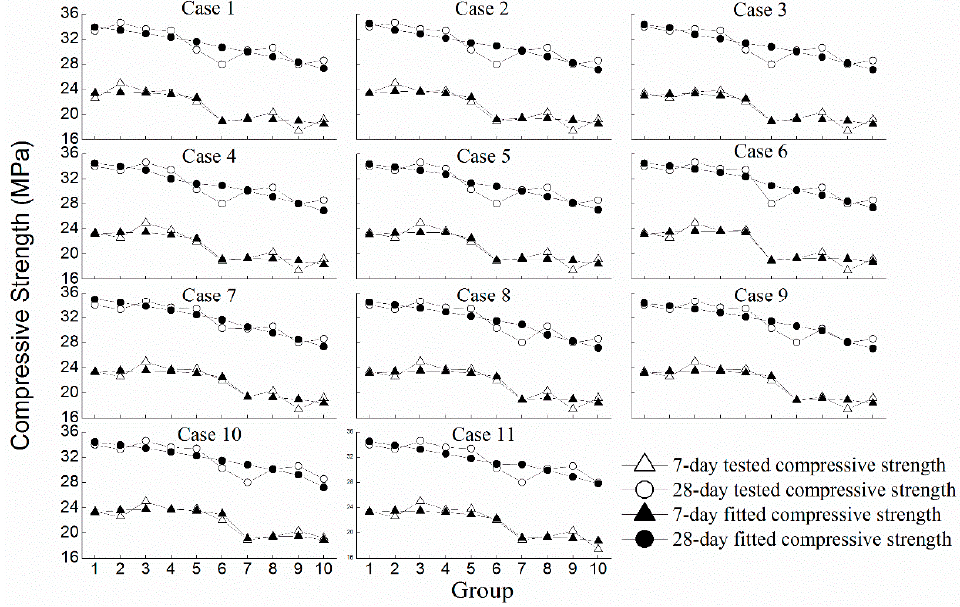
Figure 4. Comparison of tested and fitted compressive strength of concrete at age of 7 days and 28